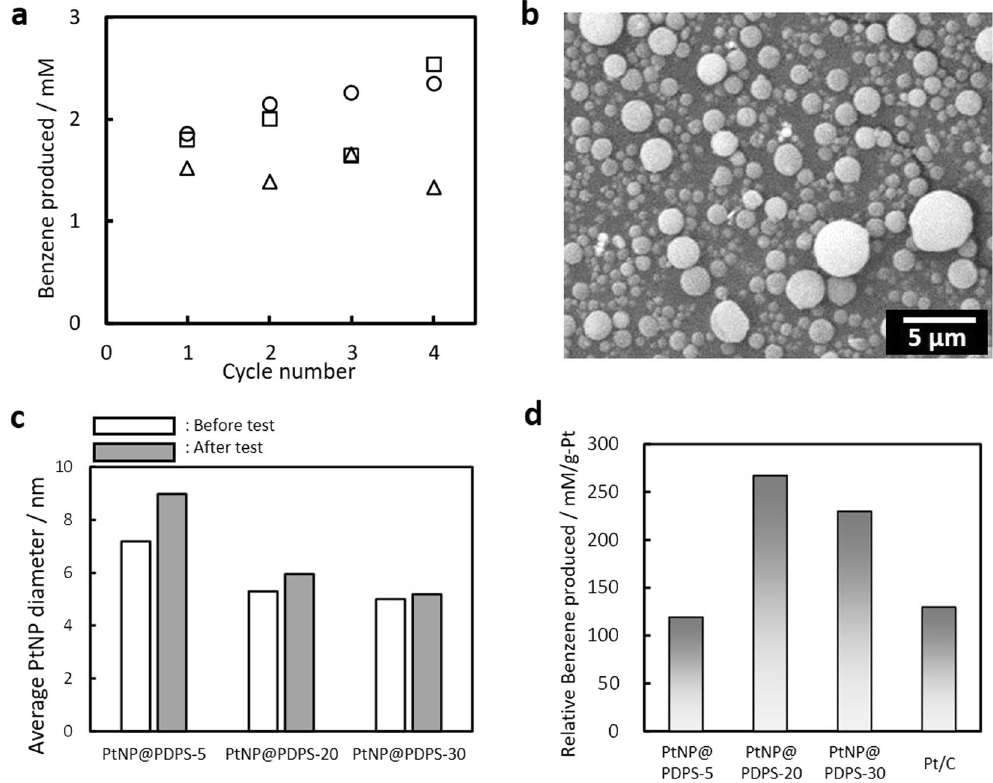
Figure 5. ( a ) Concentration of benzene produced by the dehydrogenation of cyclohexane over PtNP@PDSP catalysts as a function of cycle number for reuse tests. PtNP@PDSP-5 ( ○ ), -20 ( □ ) and -30 ( △ ). ( b ) FE-SEM image of the PtNP@PDSP catalyst after the reuse test. ( c ) Average diameter of PtNP in the PtNP@PDSPs before and after the reuse test. ( d ) Concentration of benzene produced per unit weight of Pt in the PtNP@PDSP and Pt/C catalysts.